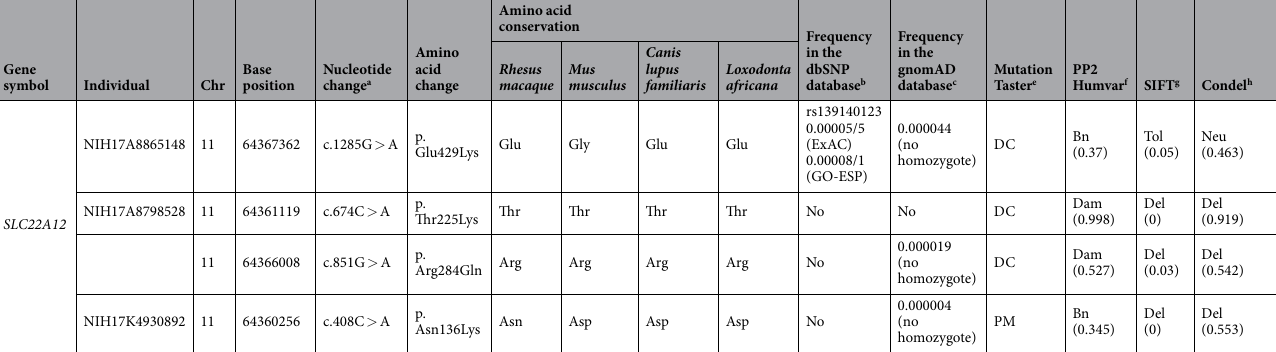
Table 3. Novel missense variants of SLC22A12 identified in individuals with renal hypouricemia via whole-exome sequencing. Abbreviations are as follows: Chr, chromosome; Bn, benign; Condel, consensus deleteriousness score of non-synonymous single nucleotide variants; Dam, damaging; DC, disease causing; Del, deleterious; Neu, neutral; PM, polymorphism; PP2, PolyPhen-2 prediction score Humvar; SIFT, sorting intolerant from tolerant; SNP, single nucleotide polymorphism; Tol, tolerant. a cDNA mutations are numbered